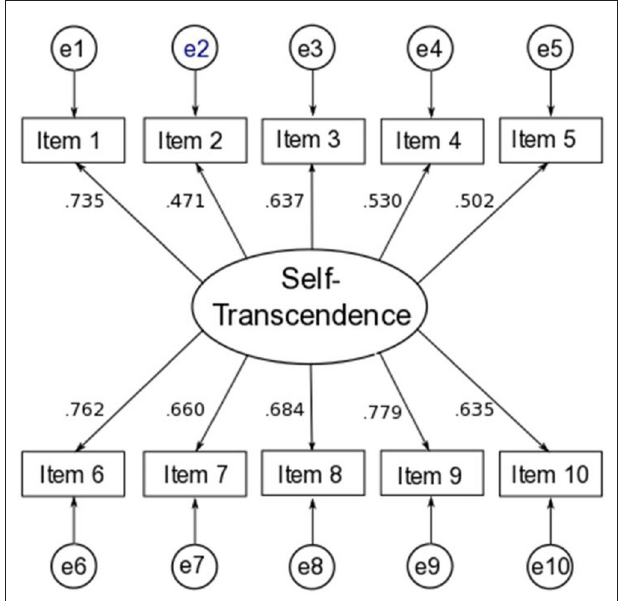
FIGURE 7 | Standardized regression weights for the one-factor model of self-transcendence ( N = 220). The models were identified by setting the factor loading of the first indicator of the latent construct to 1. The presented values are standardized by setting the variances of both the observed and latent variables to